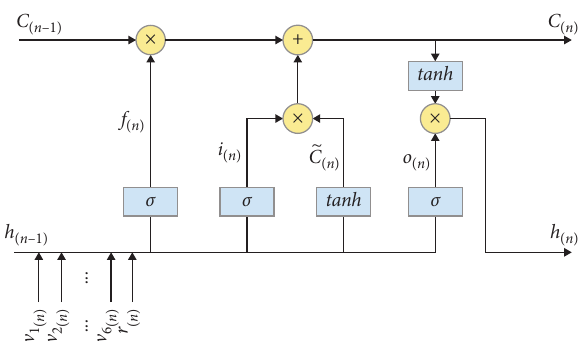
Figure 2: Framework and principle of LSTM